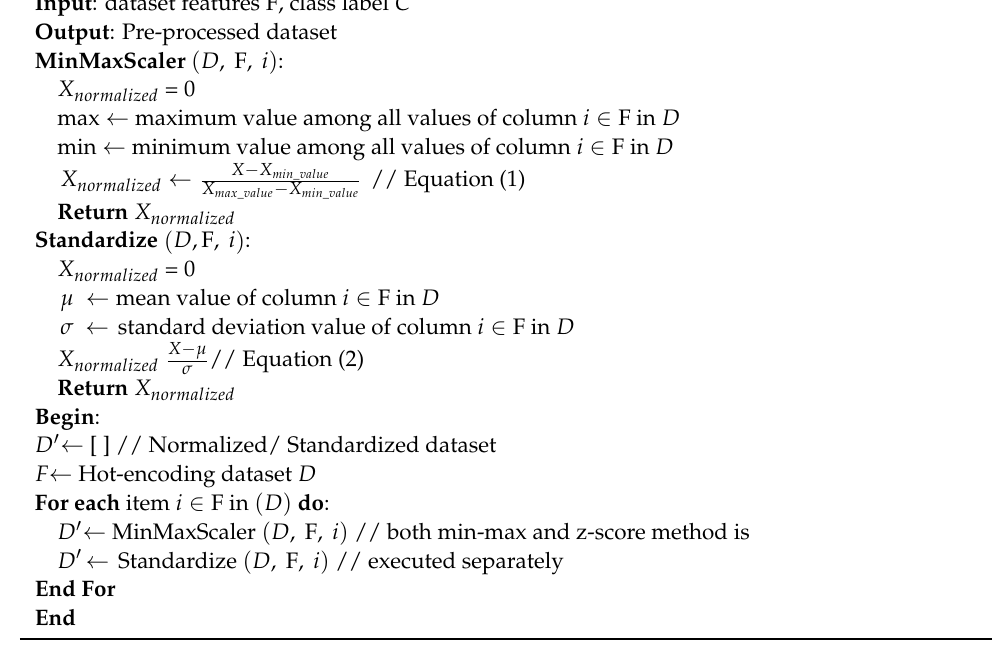
Algorithm 2 Pseudocode of One-hot encoding, Min–Max Normalization and Z-score